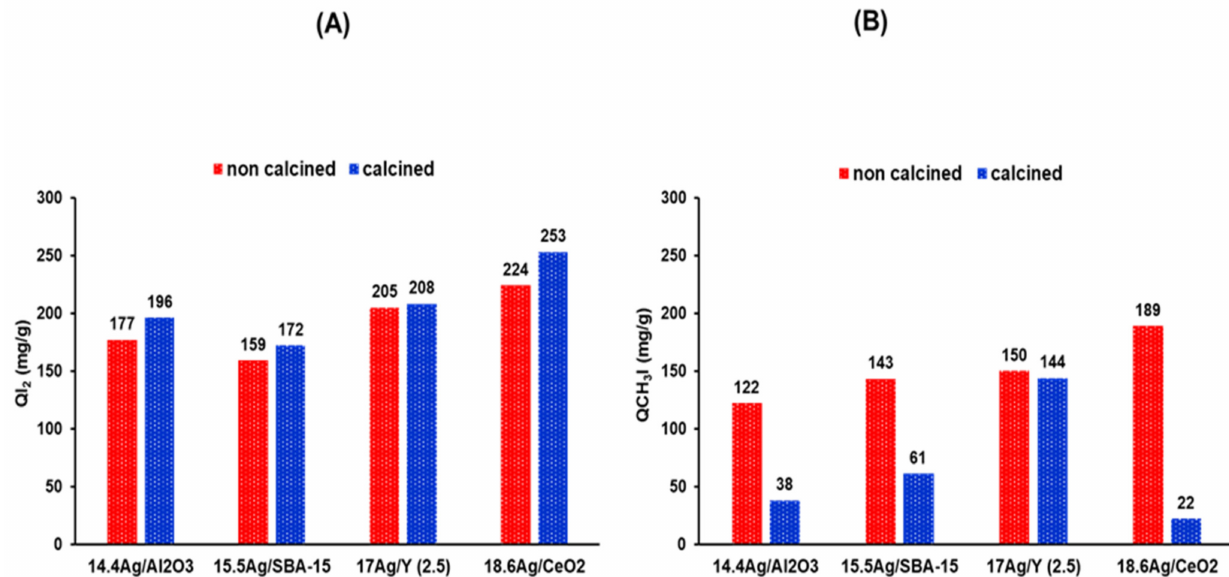
Figure 4. Influence of the thermal treatment on the performances of the investigated silver-impregnated adsorbents towards the capture of I 2 ( A ) and CH 3 I ( B